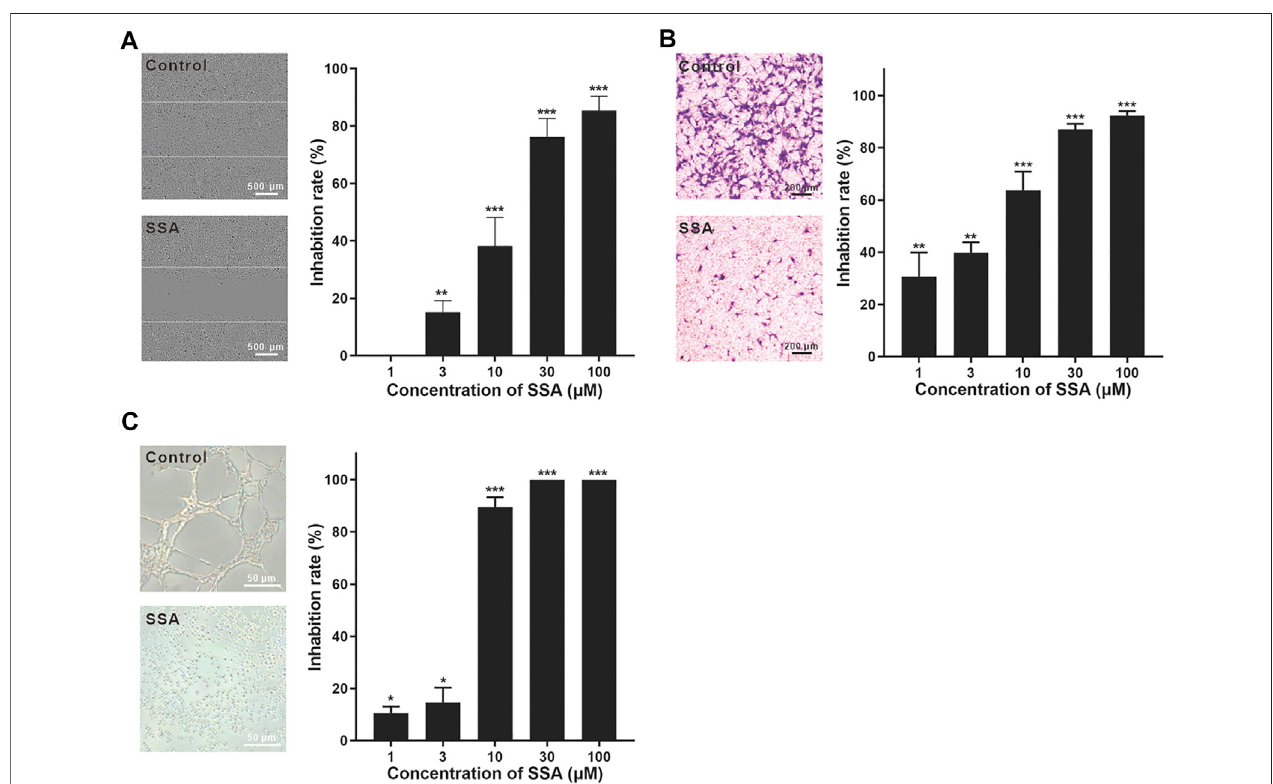
FIGURE2| SSAsigni fi cantlysuppressedHUVECmigrationandtubeformation. (A) SSAsuppressedthehorizontalmigrationofHUVECsinthewoundhealingtest. The line indicated the initial boundary of the cells. (B) SSA inhibited HUVEC migration in the Transwell assay. The migrated cells were stained with crystal violet and quanti fi ed using Image-Pro plus 8.0 software. (C) SSA inhibited HUVEC tube formation. The length of the tubular structures was photographed and quanti fi ed using Image-Pro plus 8.0 software. The photos of the control and SSA groups (30 μ M) were shown in each panel. The values are expressed as mean ± s .d. n (cid:1) 3. * p < 0.05, ** p < 0.01, and *** p < 0.001. SSA suppressed angiogenesis in the chick embryo